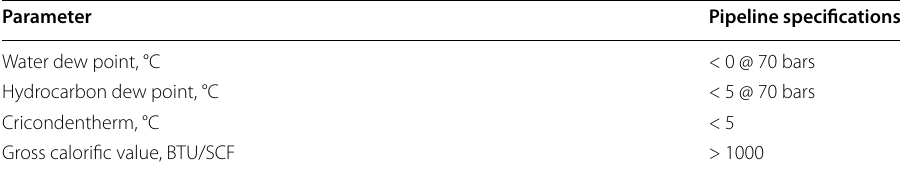
Table 1 Pipeline specifications of natural gas [11] Parameter